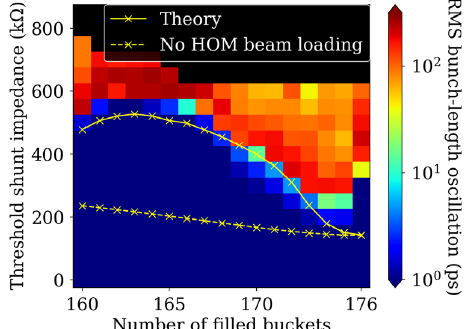
FIG. 3. Threshold shunt impedances above which a HOM- driven coupled-bunch quadrupole instability develops for differ-